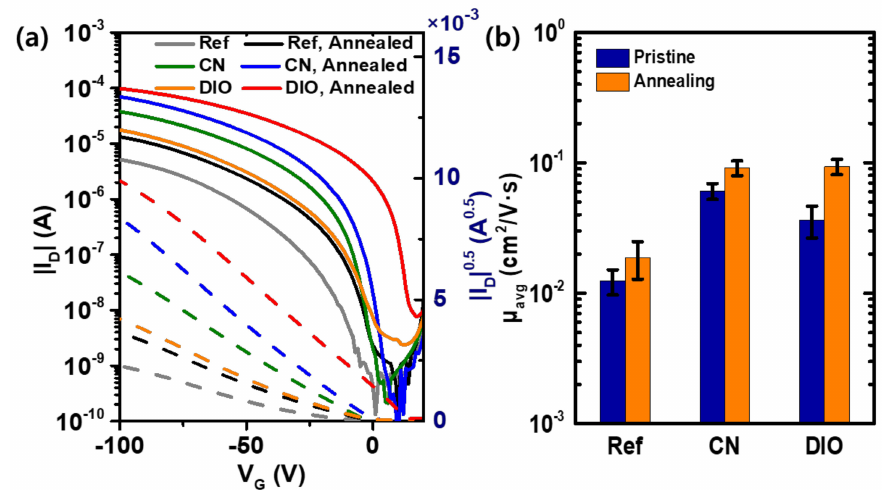
Figure 7. Effect of annealing and additive on OFET characteristics. ( a ) Transfer curves. ( b ) Comparison of hole